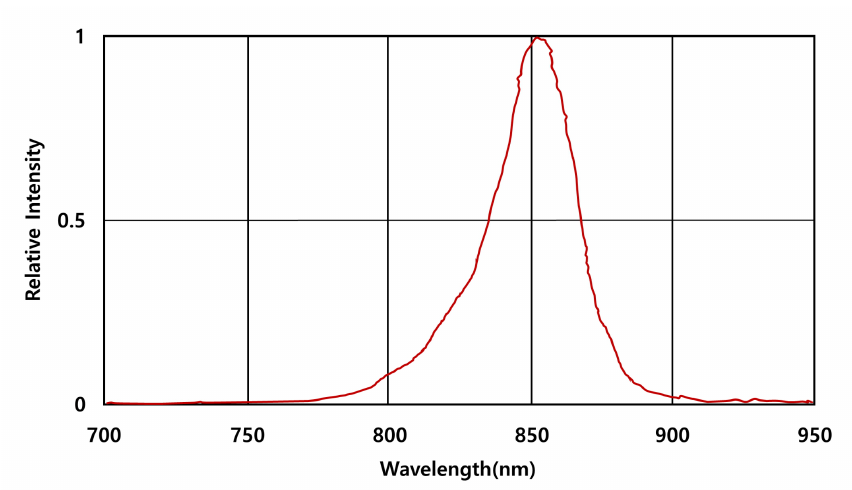
Figure 7. Graph of light wavelength measured by NIR